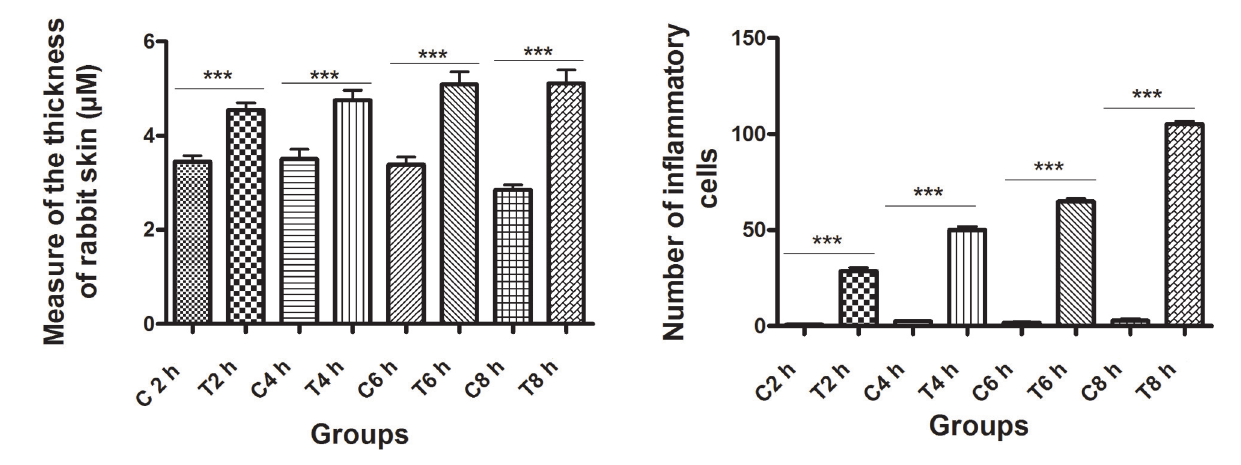
Figure 3. Skin thickness measurement for the edema quantification of the control and experimental groups 2, 4, 6 and 8 hours after injection of PBS or venom. The difference is statistically significant (***p < 0.001/ANOVA and Newman-Keuls tests). C2h, C4h, C6h and C8h = control groups 2, 4, 6 and 8 hours after PBS injection, respectively. T2h, T4h, T6h and T8h = experimental groups 2, 4, 6 and 8 hours after the venom, respectively.